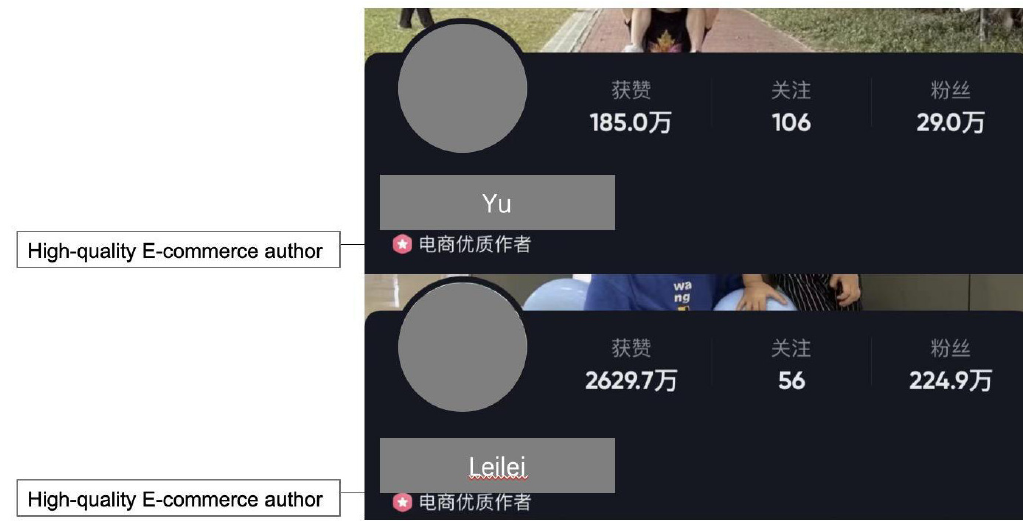
Figure 9. Yu and Leilei are certified as high‐quality e‐commerce